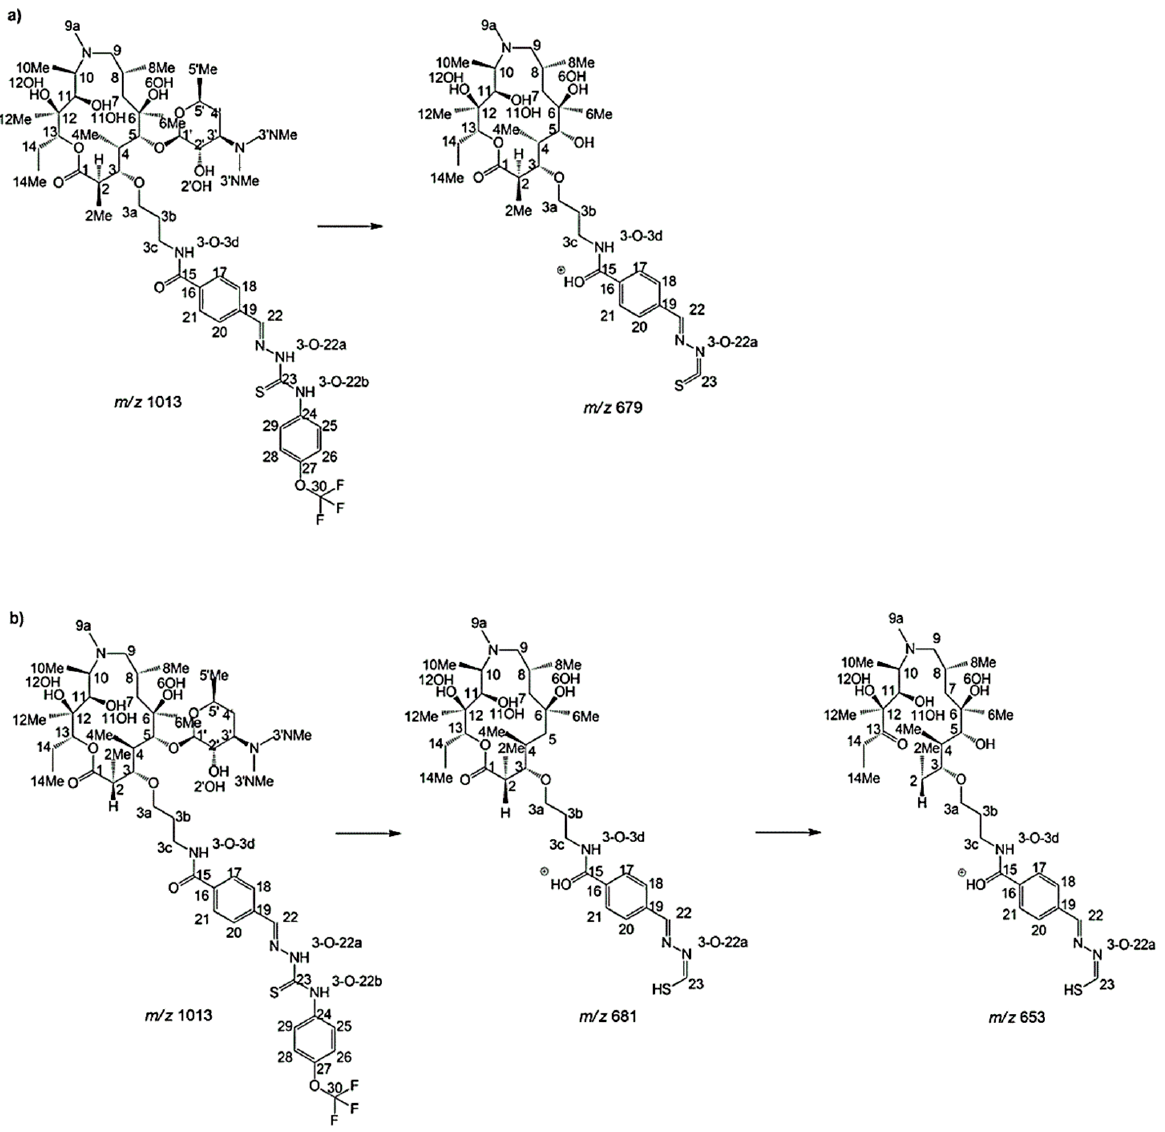
Figure 4. Fragmentation pattern observed in the MS/MS spectra of macrozones ( a ) 3a and ( b ) 3a-5 .